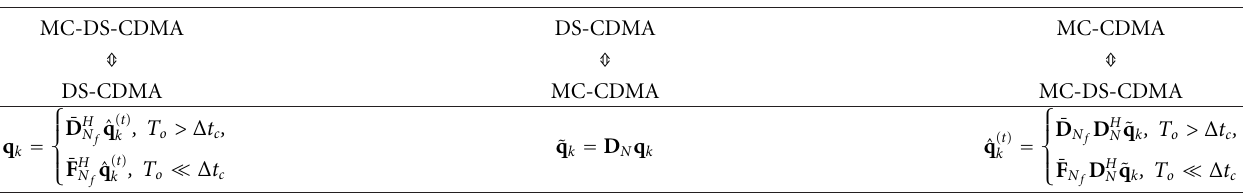
Table 3: Summary of equivalence results for a TS channel. T o refers to the duration of the basis waveform in an MC-DS-CDMA system. MC-DS-CDMA